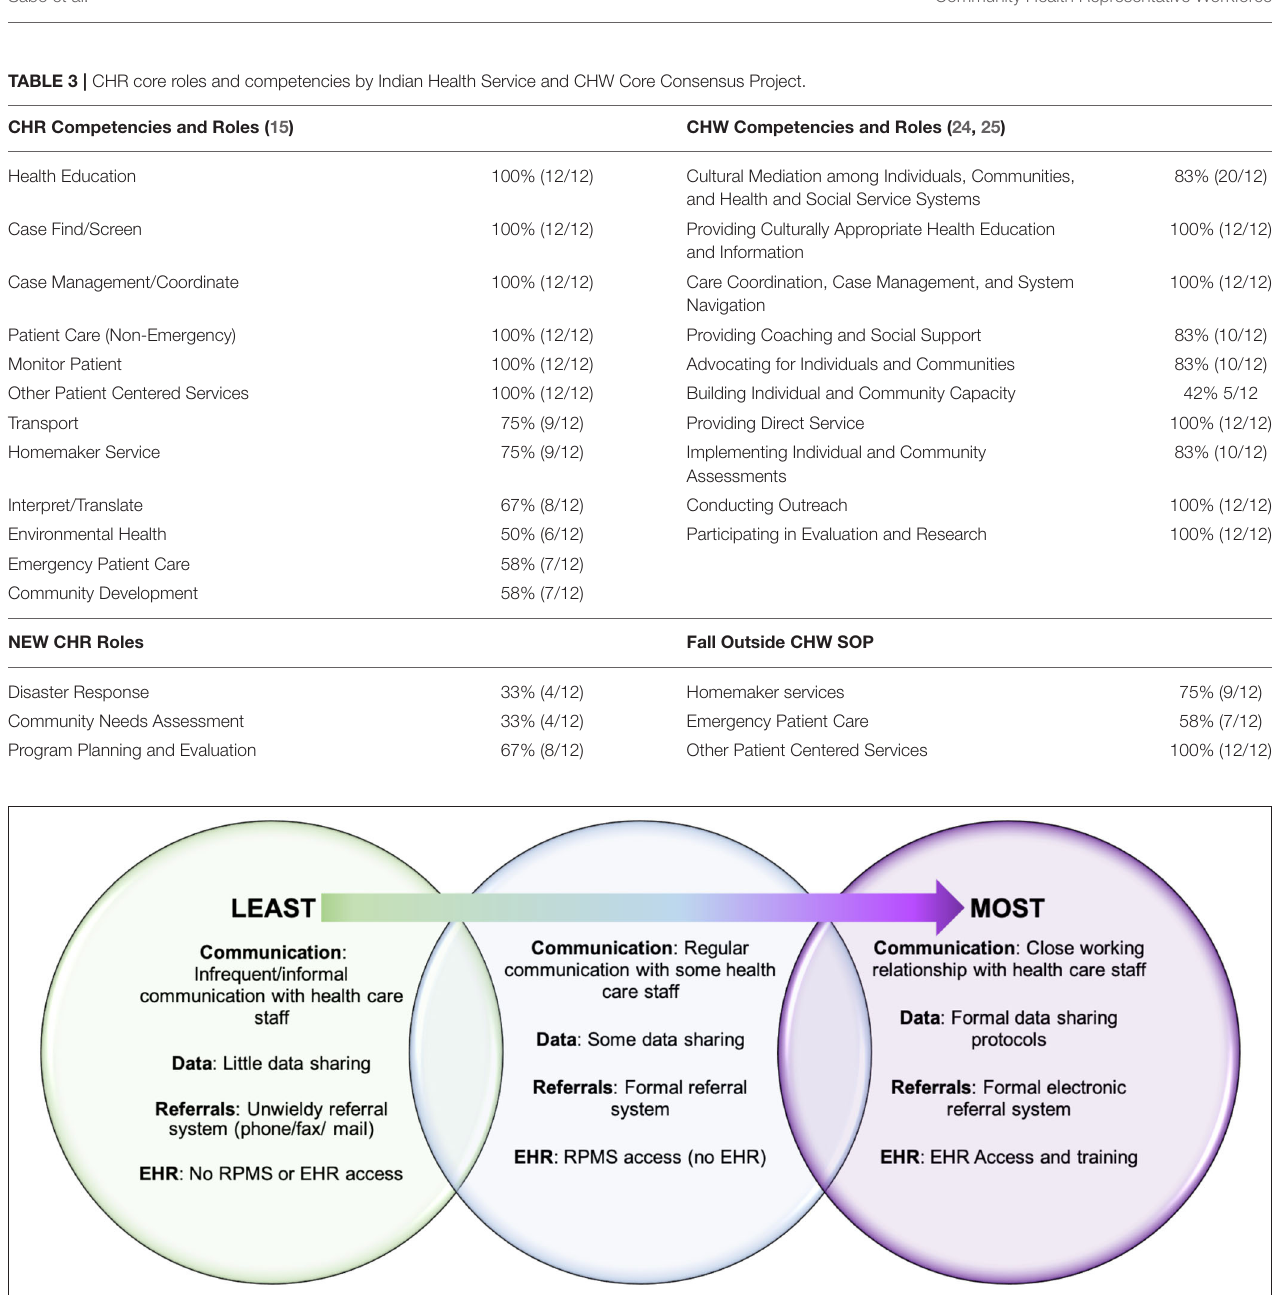
FIGURE 2 | CHR-health system integration